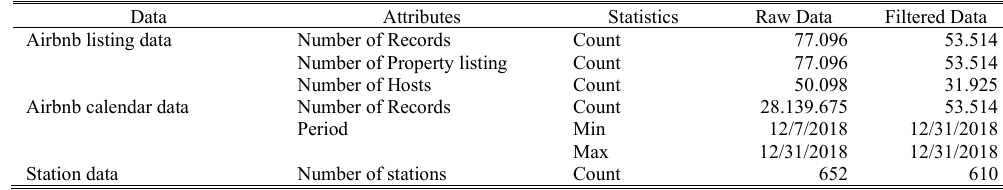
D ESCRIPTIVE S TATISTICS OF T HE D